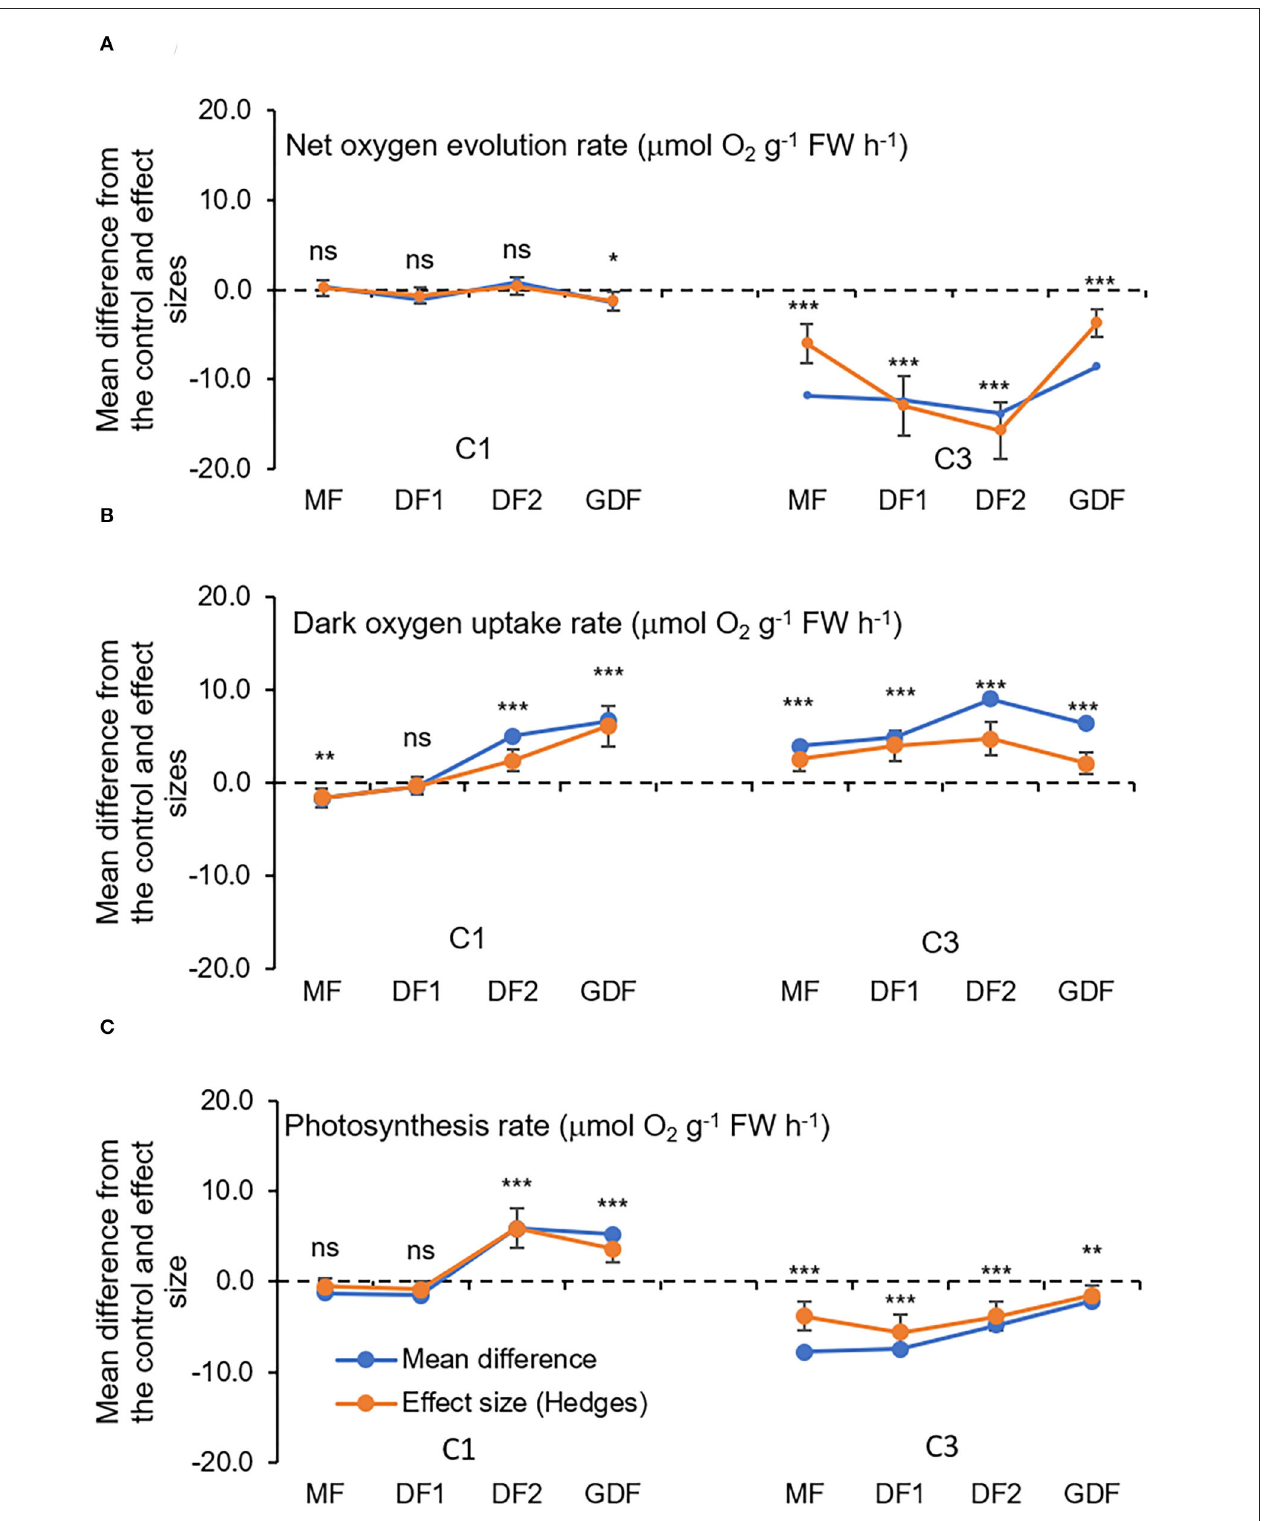
FIGURE 6 | Mean differences between Cd treatment (7 µ M, C1 and 28 µ M, C3) and the control (C0, StMo) and treatment effect sizes (Hedges d) with bias-corrected bootstrap 95% confidence interval for O 2 exchange rates( µ mol O 2 g − 1 FW h − 1 ): (A) net uptake rate during the dark period, (B) net oxygen evolution rate during the light period, and (C) apparent photosynthesis rate obtained by subtracting uptake rate from net oxygen evolution rate. Each point represents a total of nine replicates. The dashed line shows Hedges d = 0. When confidence intervals overlap zero, the effect sizes are not significantly different from zero ( p -value for mean difference is obtained by 2-tailed t -test, ns for * p < 0.05; ** p < 0.01; *** p < 0.001).